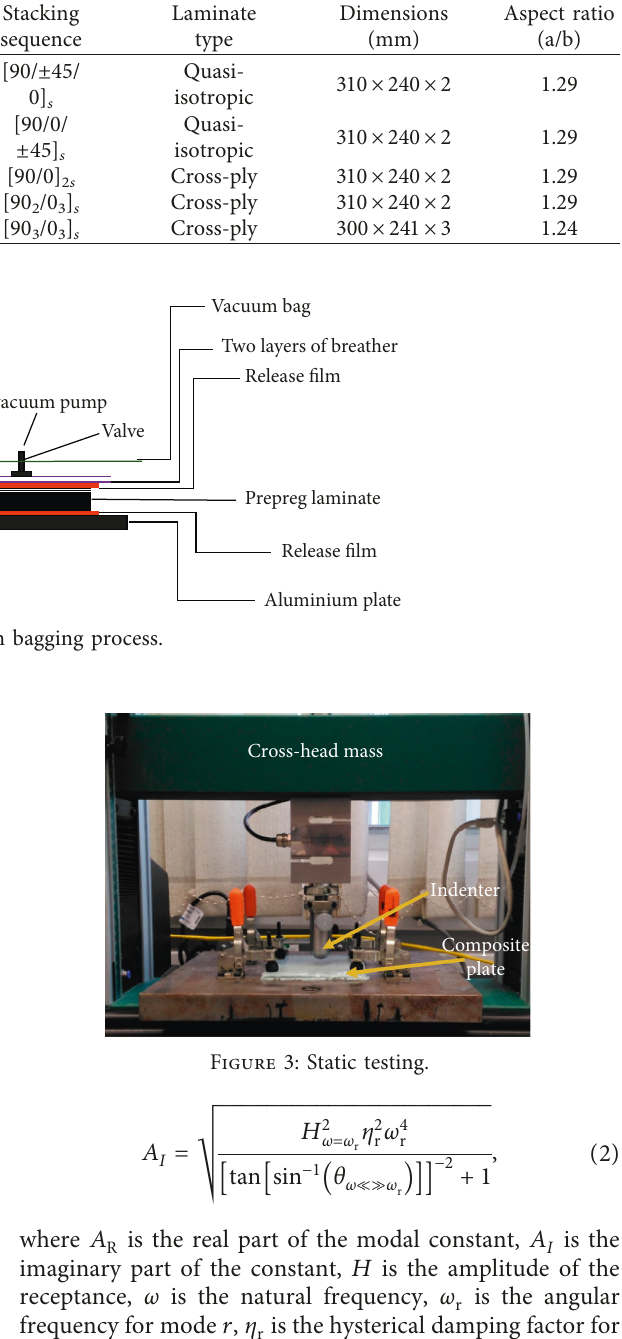
Table 1: Types of specimens and designations.